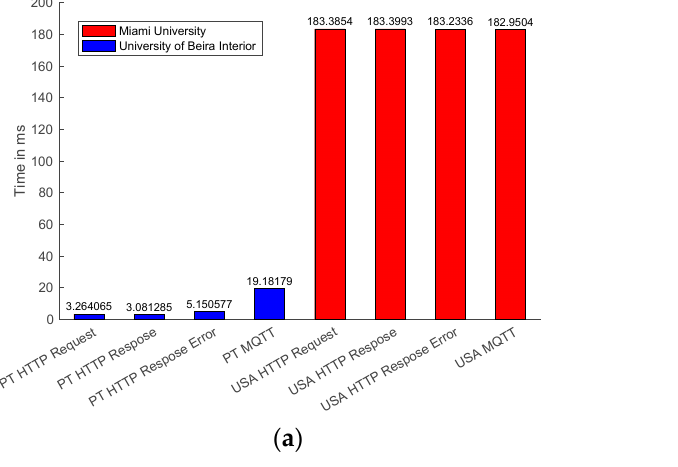
Figure 8. Mean of latency request and response.